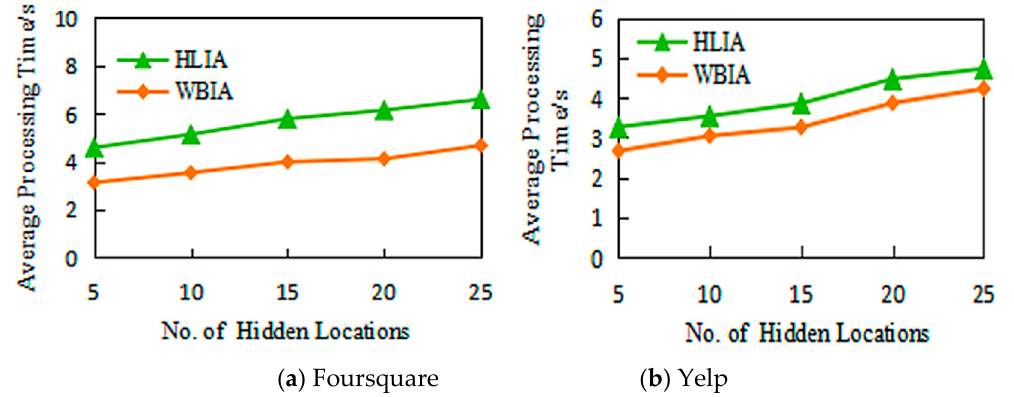
Figure 5. Efficiency. Figure 5. E ffi